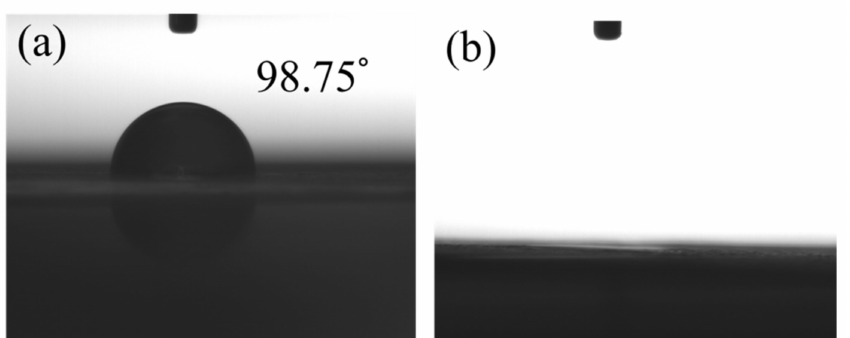
Figure 3. The images of contact angles measurements for ( a ) non-modified and ( b ) APPJ-modified graphite